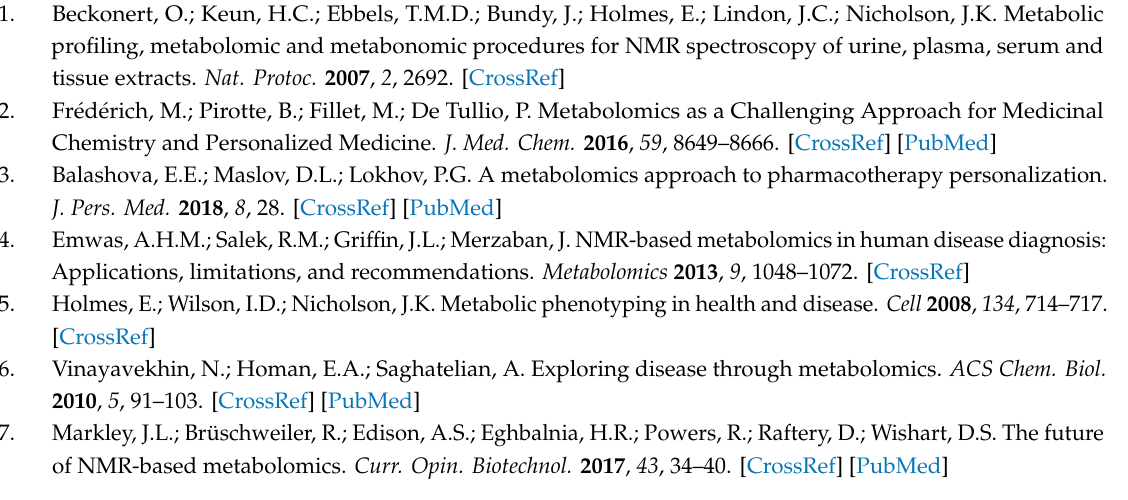
Figure S1: Urinary spectra of diabetic patient acquired at 60 (red, upper panel) and 400 MHz (blue, lower panel). Table: 1 H NMR assignments for identified metabolites. Legend: s: singlet, d: doublet, t: triplet, m: multiple, dd: doublet of